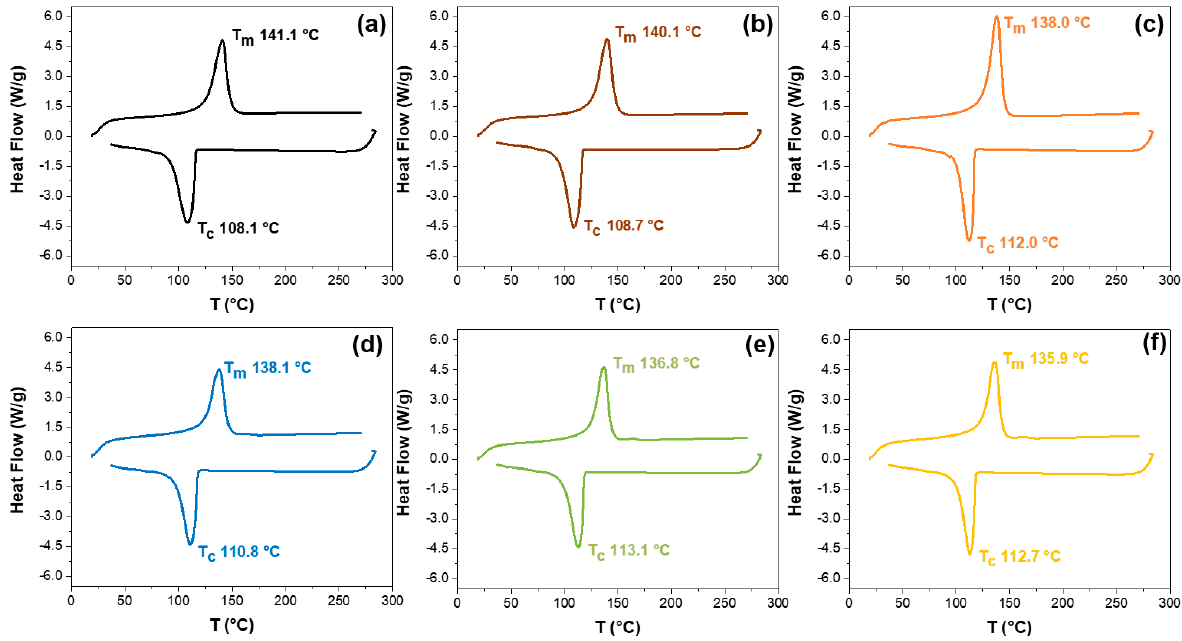
Figure 5. Effect of recycling and addition of Cu-NPs on the differential scanning calorimetry of ( a ) HDPE, ( b ) HDPE 0.5 wt.% Cu-NPs, ( c ) HDPE 0.7 wt.% Cu-NCs, ( d ) rHDPE, ( e ) rHDPE 0.5 wt.% Cu-NPS, and ( f ) rHDPE 0.7 wt.% Cu-NCs.